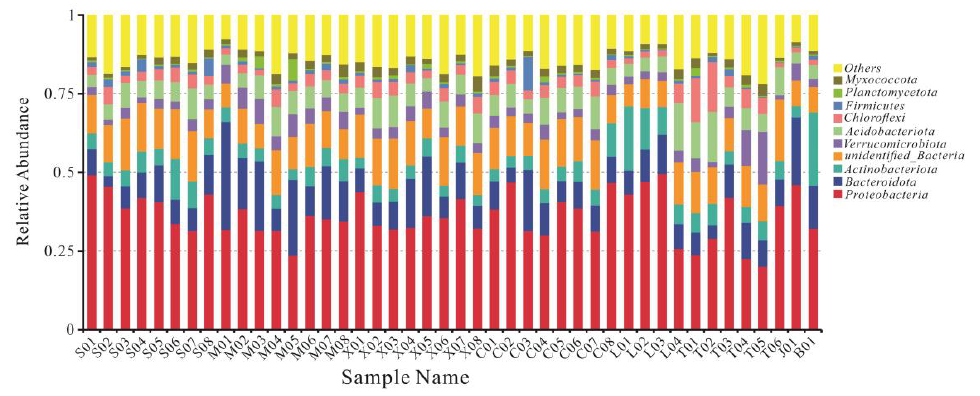
Figure 5. Relative abundances of phyla present in samples.